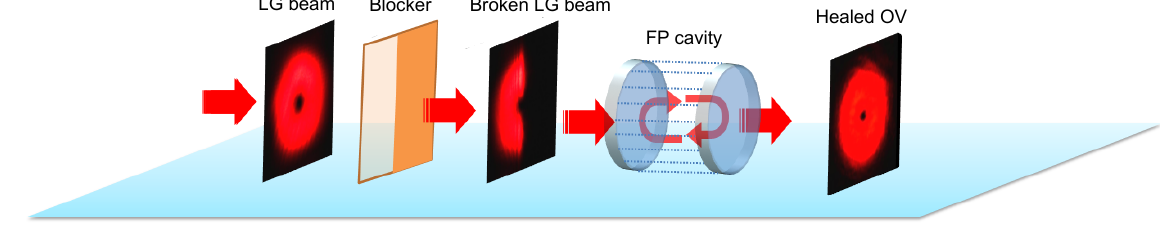
Fig. 1 | Conceptual diagram of a blocked LG beam healing system using a FP cavity . The blocked OV beam travels hundreds of times (depending on the q factor of the resonator) in the cavity when resonating. As the beam propagates back and forth, the blocked parts of the beam are